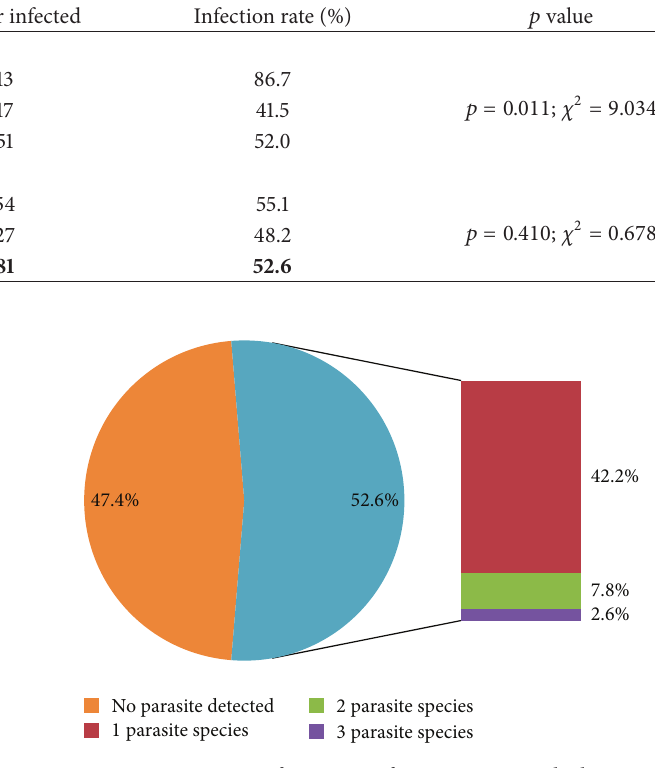
Figure 3: Pattern of parasitic infection among study